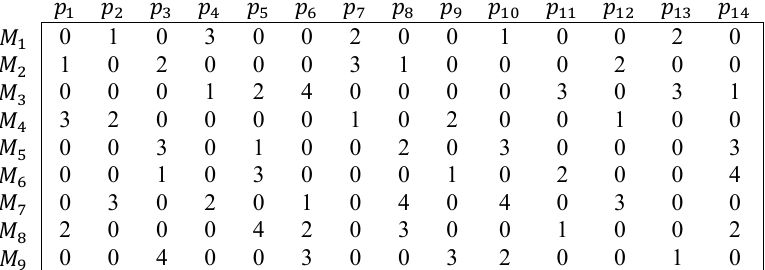
Exceptional Displacement Time parts of parts